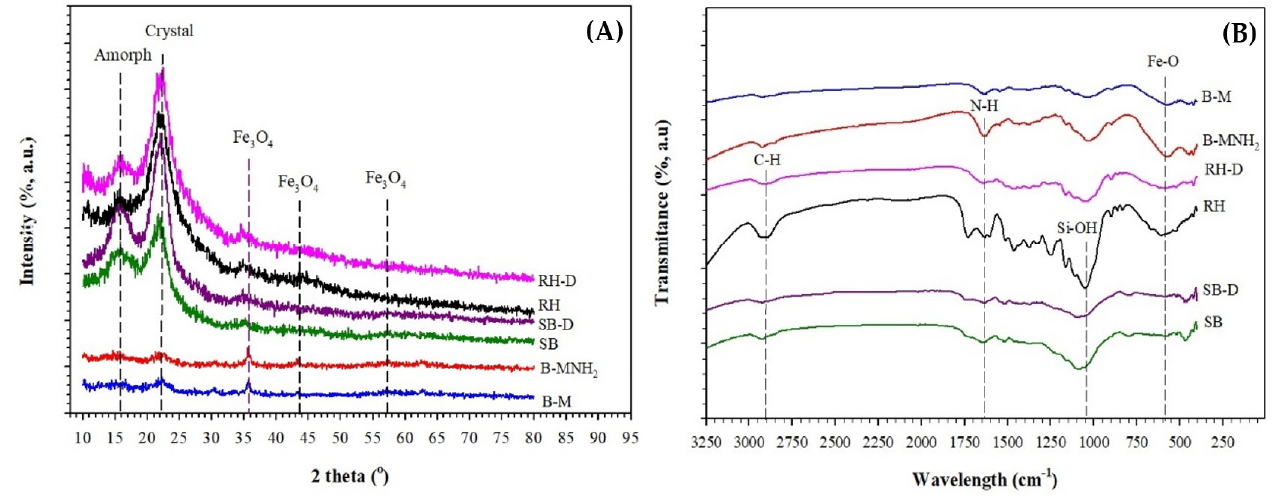
Figure 3. ( A ) X-ray diffraction (XRD) spectra and ( B ) FT-IR spectra of rice husk (RH), delignified rice husk (RH-D), sugarcane bagasse (SB), delignified sugarcane bagasse (SB-D), magnetic biocomposite (B-M), and amine magnetic biocomposite (B-MNH 2 Table 1. Characteristic peaks of rice husk (RH), delignified rice husk (RH-D), sugarcane bagasse (SB), delignified sugarcane bagasse (SB-D).